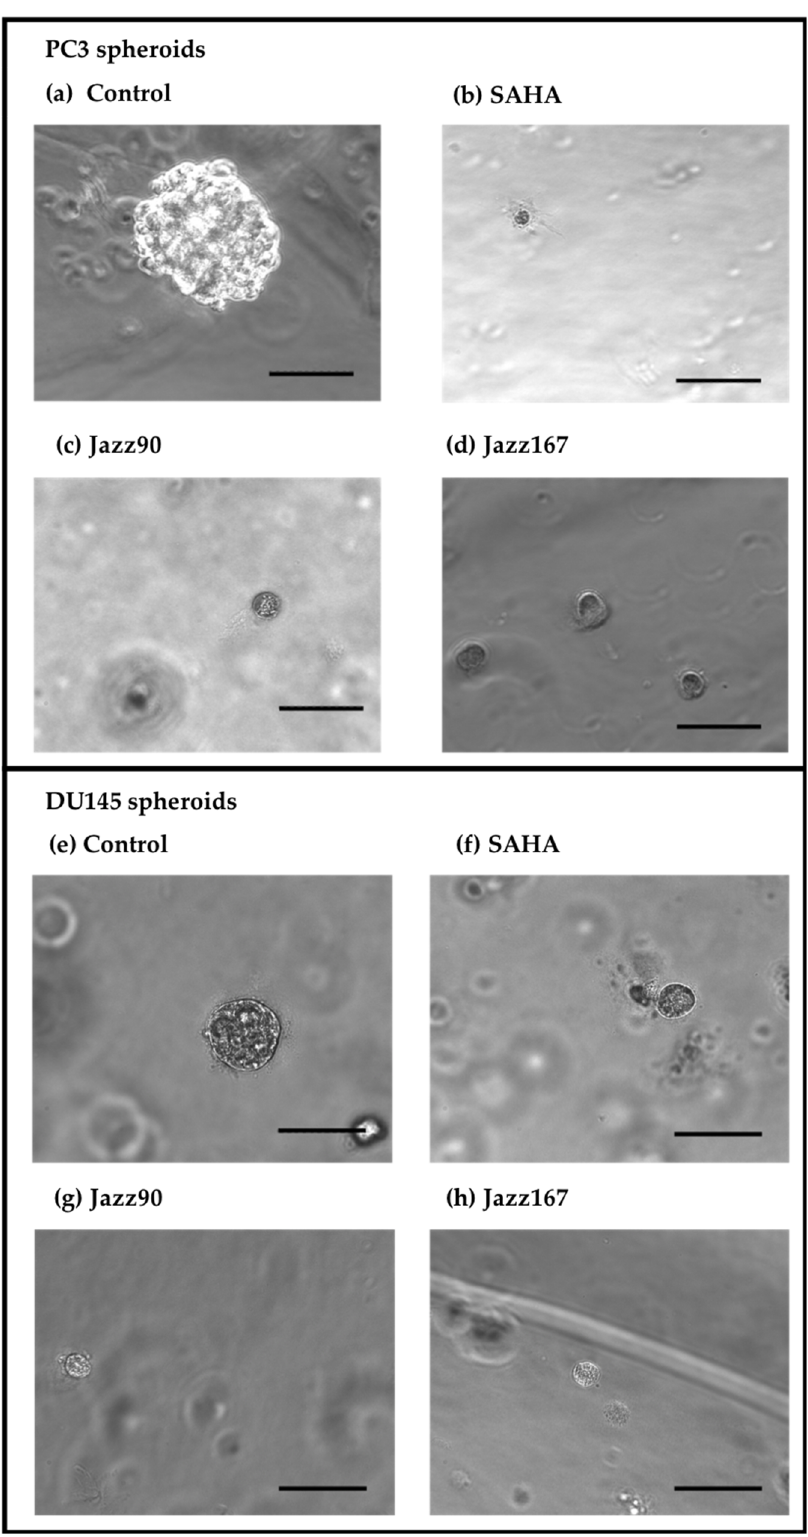
Figure 5. Effect of HDAC inhibitors on PC3 and DU145 spheroids. Jazz90, Jazz167 and SAHA (4 µM) incubated with PC3 and DU145 spheroids grown in Matrigel for one week. Control cells were treated with 0.5% DMSO. Representative images from ( a , e ) Control, ( b , f ) SAHA, ( c , g ) Jazz90 and ( d , h ) Jazz167 are shown. The black bars indicate 100 µm at a magnification of × 200. Three independent experiments were carried out.